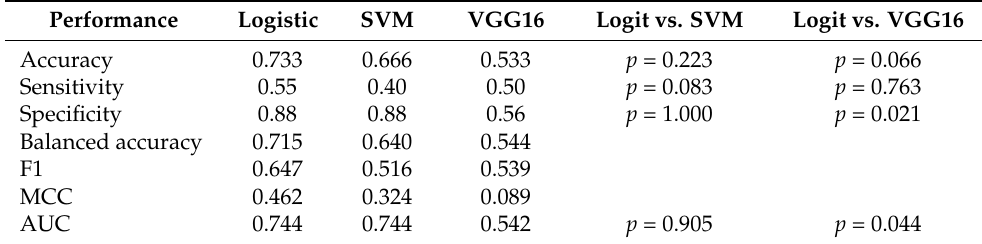
Figure 5. ROC curves of logistic regression, SVM and VGG16 model and confusion matrix of the logistic regression model for identifying hepatocellular carcinoma (HCC) metastasis on the external validation set. 4. Discussion In the present study, we explored the possibility of using radiomics in contrast-en- hanced CT to be a predictive indicator for metastasis disease in HCC patients. A radiomic